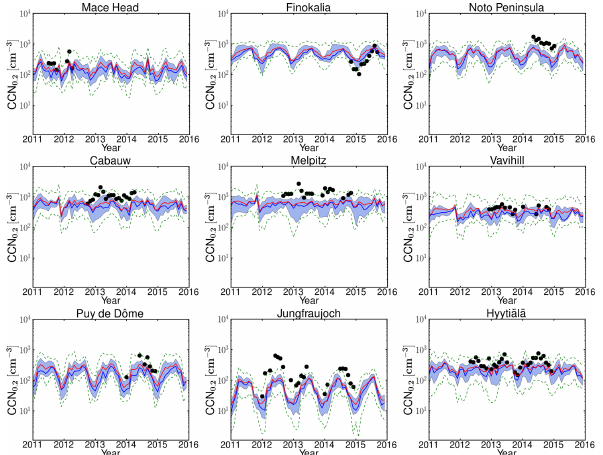
Figure 3. Comparison of the seasonal variations of the observed and model median computed CCN 0 . 2 . The solid bars show the average of the observed CCN 0 . 2 during each season and the shaded bars the corresponding averages of the model results. The simulated CCN 0 . 2 concentrations have been scaled by a factor, f (denoted in each graph), so that the four-season mean is the same as the observed one. For Puy de Dôme the normalization is based on the mean of three seasons (winter, summer and fall) due to data